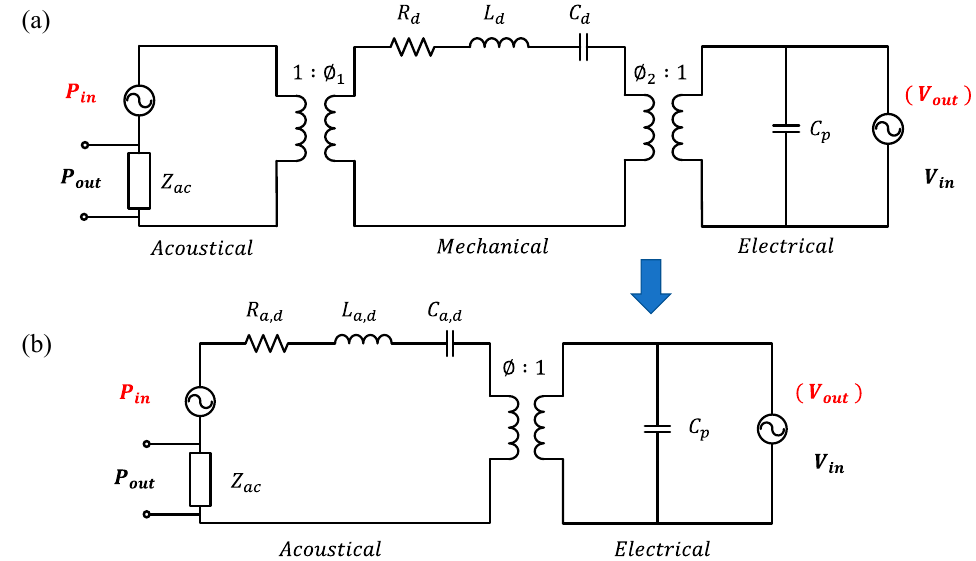
Figure 18. Lumped element modeling (LEM) circuit mode of a pMUT in three domains ( a ), and two domains ( b ).